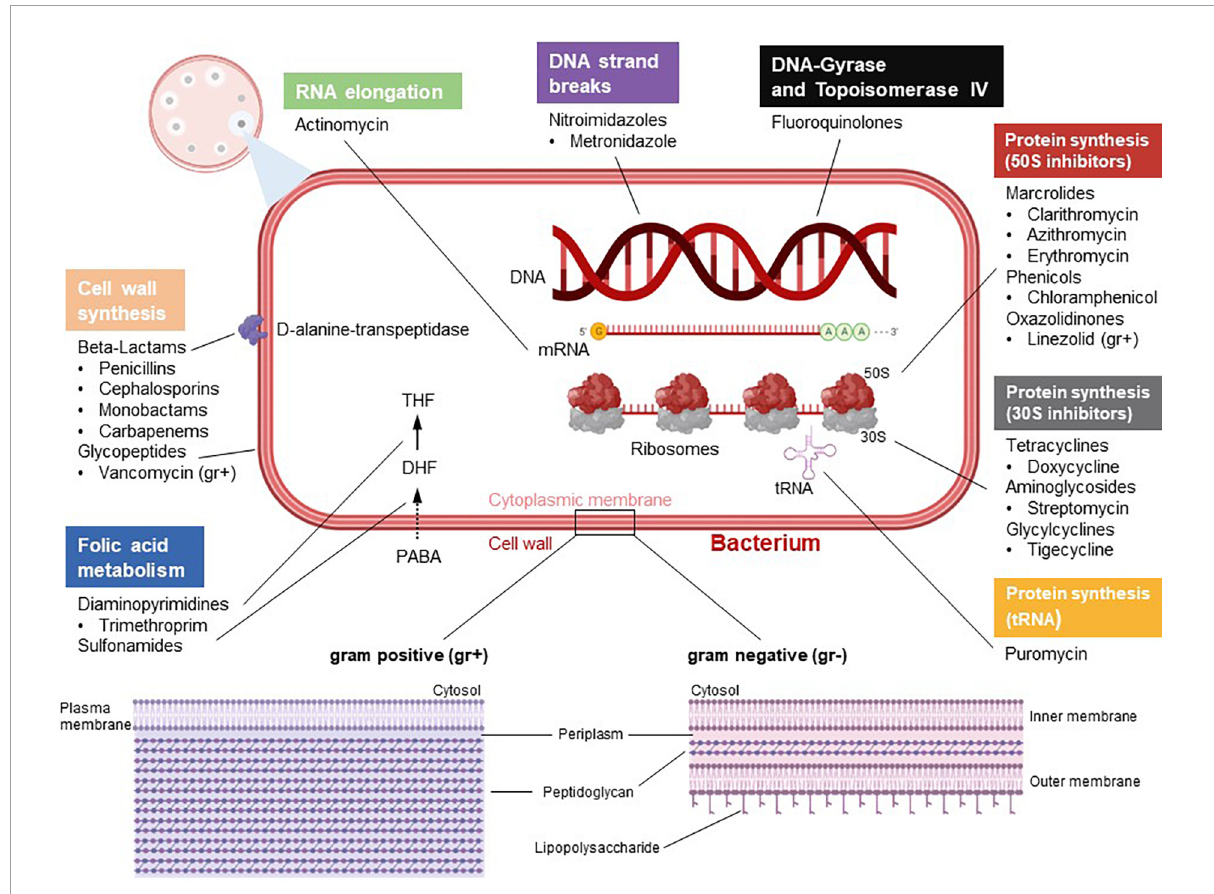
FIGURE1 Categorization and mode of actions of antibiotics. According to their barrier structure, bacteria can be divided into gram positive (gr +) and gram negative (gr–). Antibiotics differ in terms of their mechanisms. Some antibiotics target the bacterial cell wall. Beta-lactam antibiotics directly inhibit the enzyme D-alanine-transpeptidase, which impedes cross-linking of building blocks in bacterial murein synthesis. Glycopeptides such as vancomycin, which only attack gram positive bacteria, inhibit bacterial cell wall synthesis by complex formation with murein components. Diaminopyrimidines, e.g., trimethoprim, inhibiting the enzyme dihydrofolate reductase, and sulfonamides, which target the diydropteroatsynthase, inhibit bacterial tetraydrofolate (THF) synthesis and, hence, DNA synthesis. Fluoroquinolones negatively regulate the bacterial enzymes topoisomerase II (gyrase) and topoisomerase IV, which impairs DNA replication. Actinomycin has cytostatic capabilities by intercalating into DNA and thus inhibiting RNA elongation. Moreover, certain antibiotics impede bacterial protein synthesis through binding to 70S ribosomes. In this context, macrolides, phenicols and oxazolidiones inhibit the large 50S subunit, whereas tetracyclins, aminoglycosides and glycylcylins are potent 30S inhibitors. In addition, drugs like puromycin interfere with tRNA function and thus represent another mechanism of protein synthesis inhibition. Metronidazol induces DNA strand breaks. The figure was created with